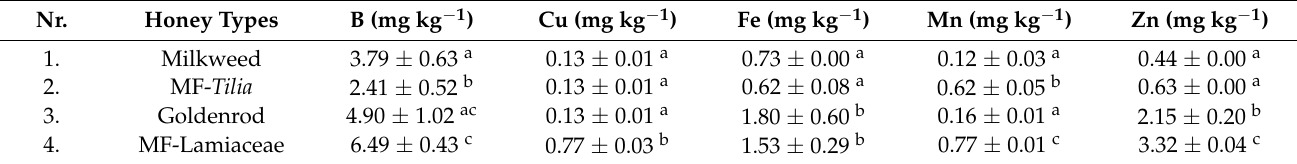
Table 5. Microelement content of honey samples. Table 4. Macroelement content of the studied honey samples.